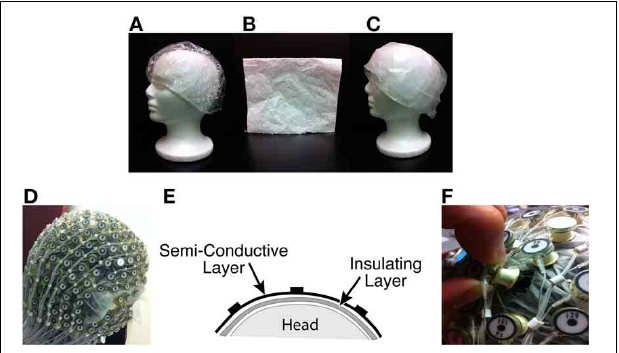
FIGURE 1 | (A) Insulation layer: a shower cap (B) Semi-conducting layer: paper layer (C) A piece of thin paper dampened with saline placed on top of the insulation layer (D) A picture with all channels blocked (E) Sandwich diagram of construction (F) Unblocking one